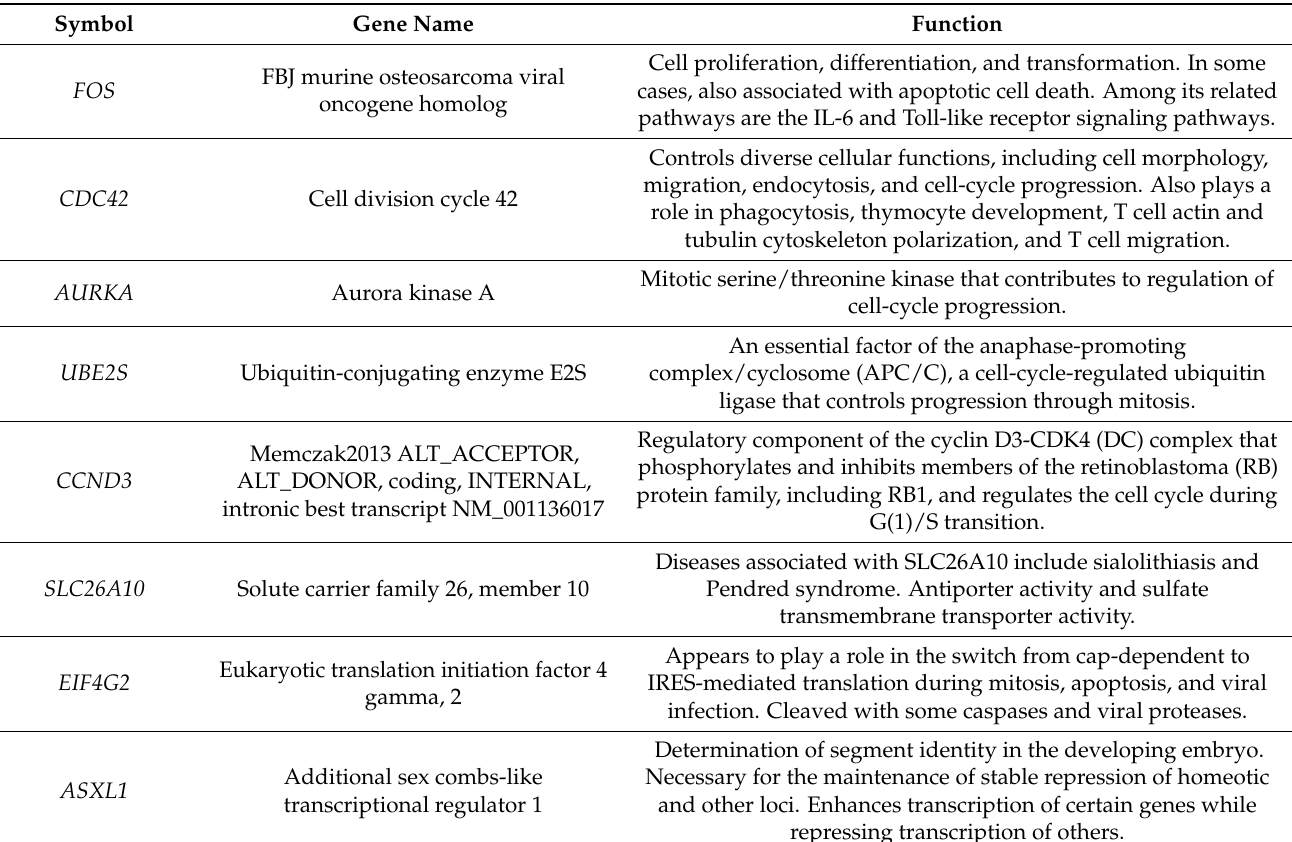
Table 4. Functional roles for hub genes of transcriptional differences in whole blood associated with mortality in community-acquired